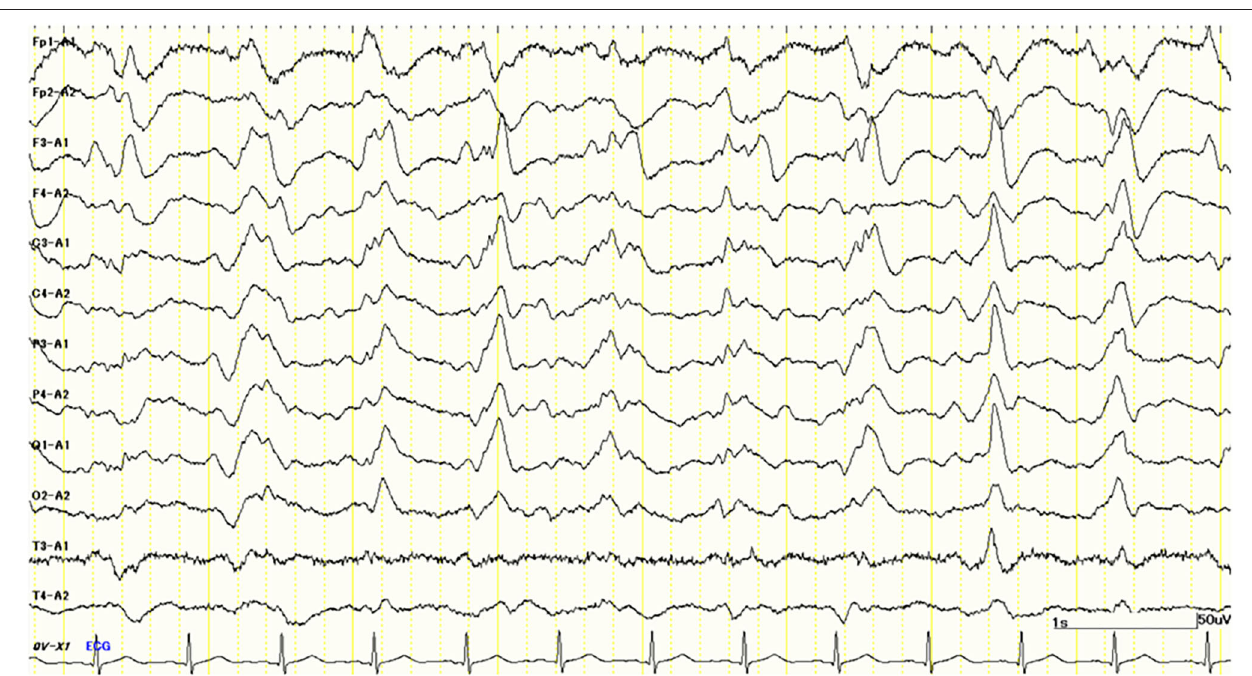
FIGURE 2 | Electroencephalography (EEG) study 1.5 months after admission shows periodic synchronous discharge (PSD) suggesting Creutzfeldt–Jakob disease